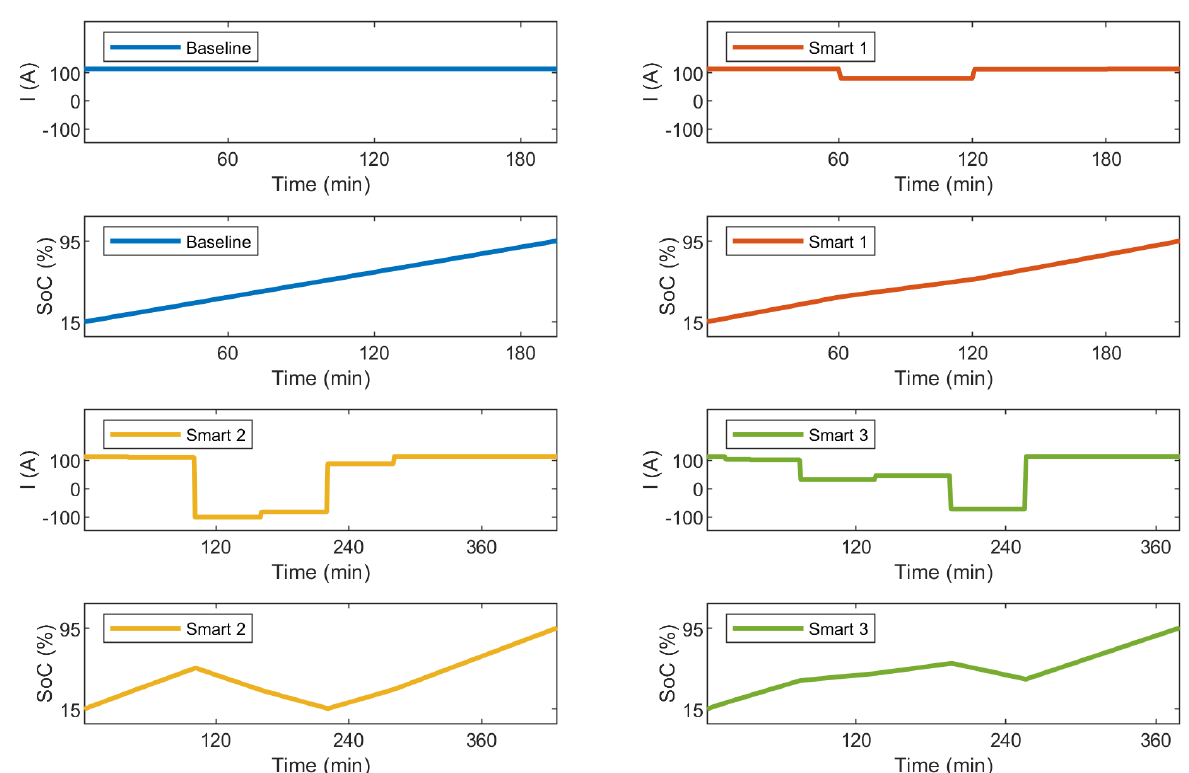
Figure 6. Charging current profiles used for the reliability analysis.